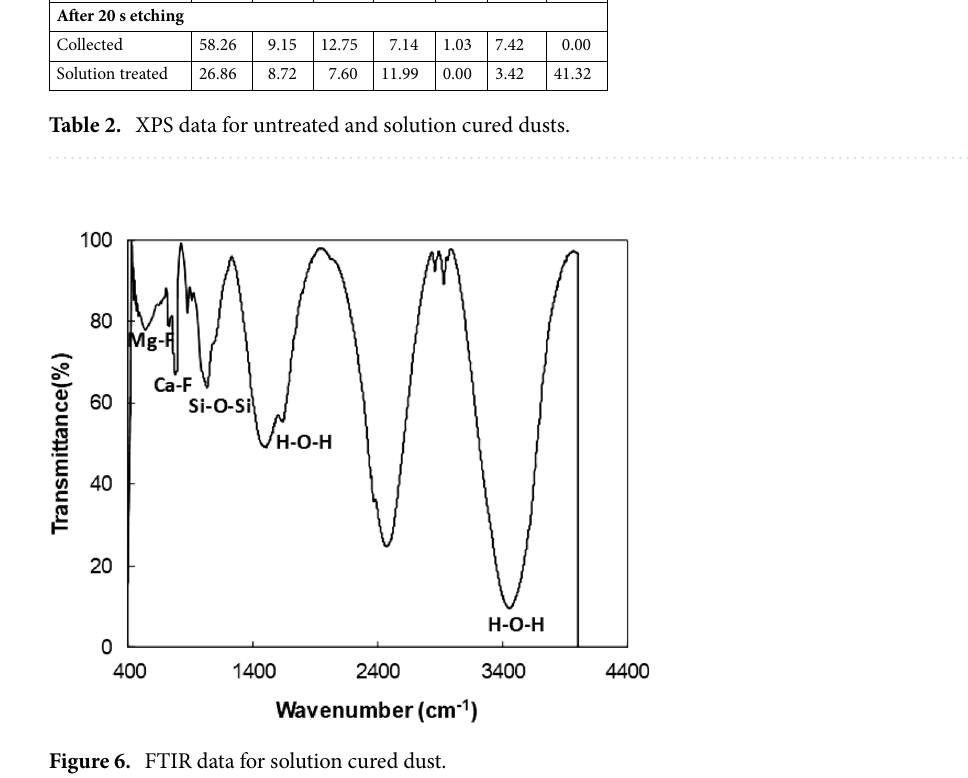
Figure 6. FTIR data for solution cured